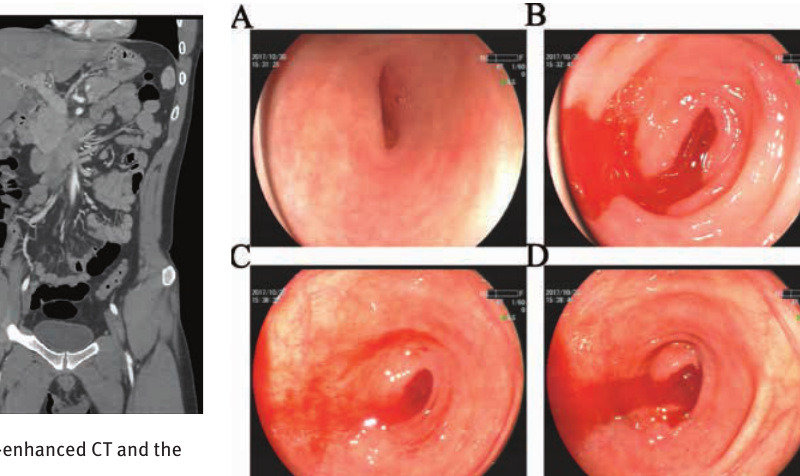
Figure 2: Colonoscopy showed that blood came from the appen- diceal orifice with time. (A) Irrigation washed away the blood. (B) Oozing bright blood puffed at the appendiceal orifice. (C) Repetitive irrigation couldn’t clear away the blood. (D) After about 10 seconds, oozing bright blood flowed away from the appendiceal